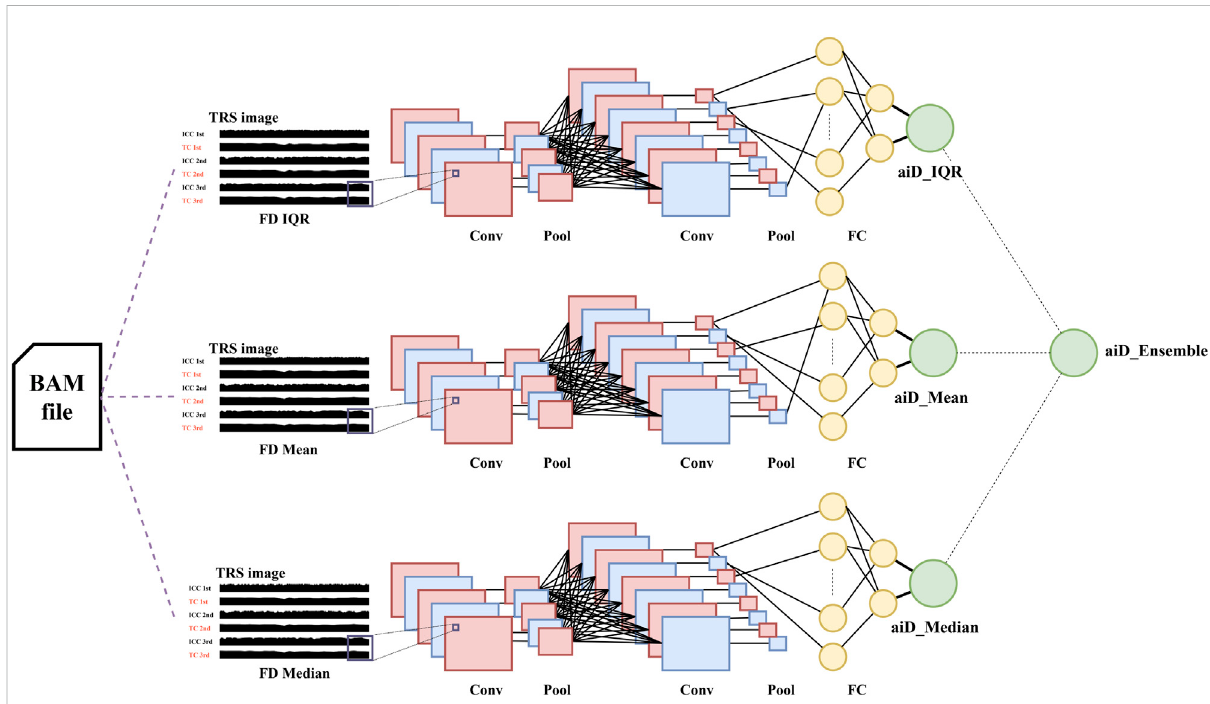
FIGURE 4 aiD-NIPT training and ensemble process. Through target repeat stacking (TRS) image generation using the fragment distance (FD) representative values (mean, median, and IQR), the respective convolutional neural network algorithms were produced. Convolutional Neural Network(CNN)consistsoftheconvolutionprocessandaneuralnetwork.Intheconvolutionprocess,theconvolution(Conv)andmaxpooling(Pool) processes are repeated. Thereafter, a fully connected layer (FC) is created and neural network analysis is performed. The median of the probability values was used for the ensemble. aiD: arti fi cial intelligence of fragment distance; BAM: the binary version of a SAM fi le;